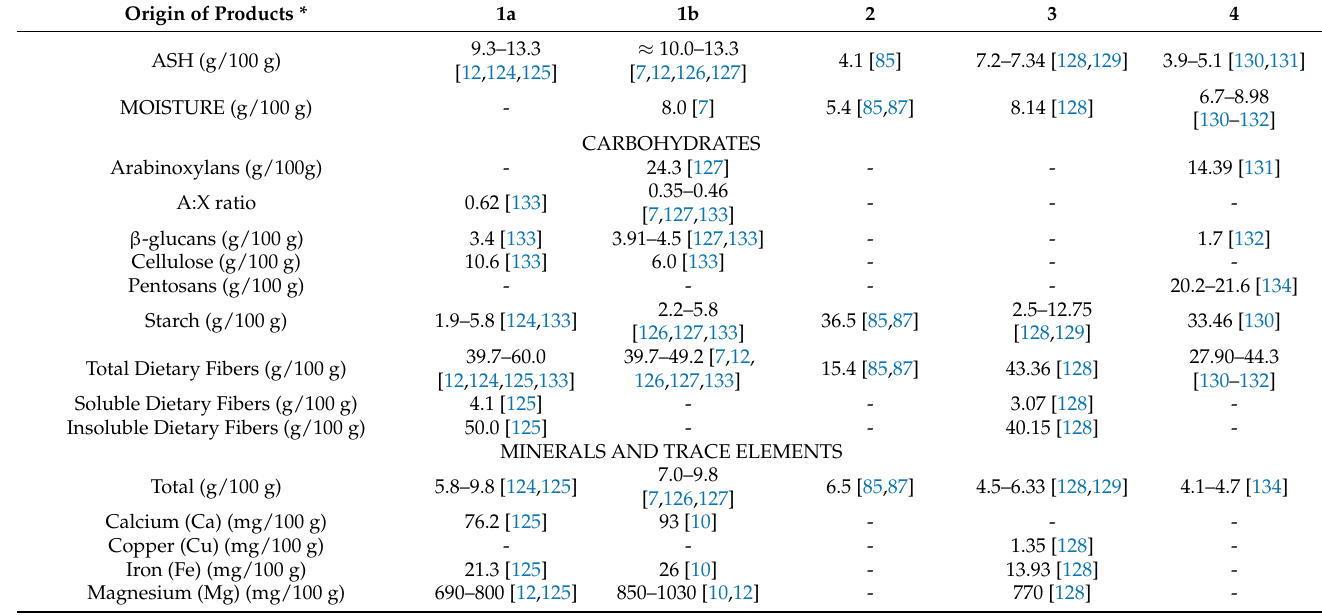
Table 7. Composition of aleurone-enriched fractions issued from different extracting processes in